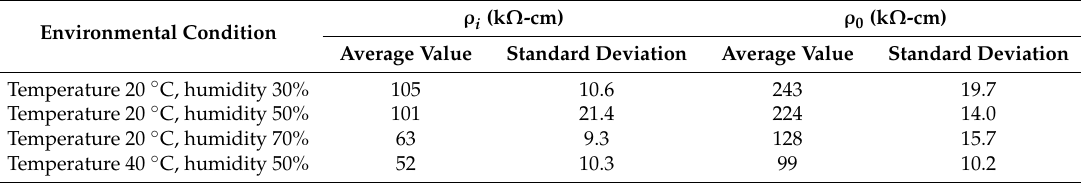
Figure 12. Dependence of electrical resistivity on environmental condition of MSFRC: ( a ) Effect of relative humidity; ( b ) Effect of temperature. Table 6. Electrical resistivity of studied MSFRCs regarding temperature and